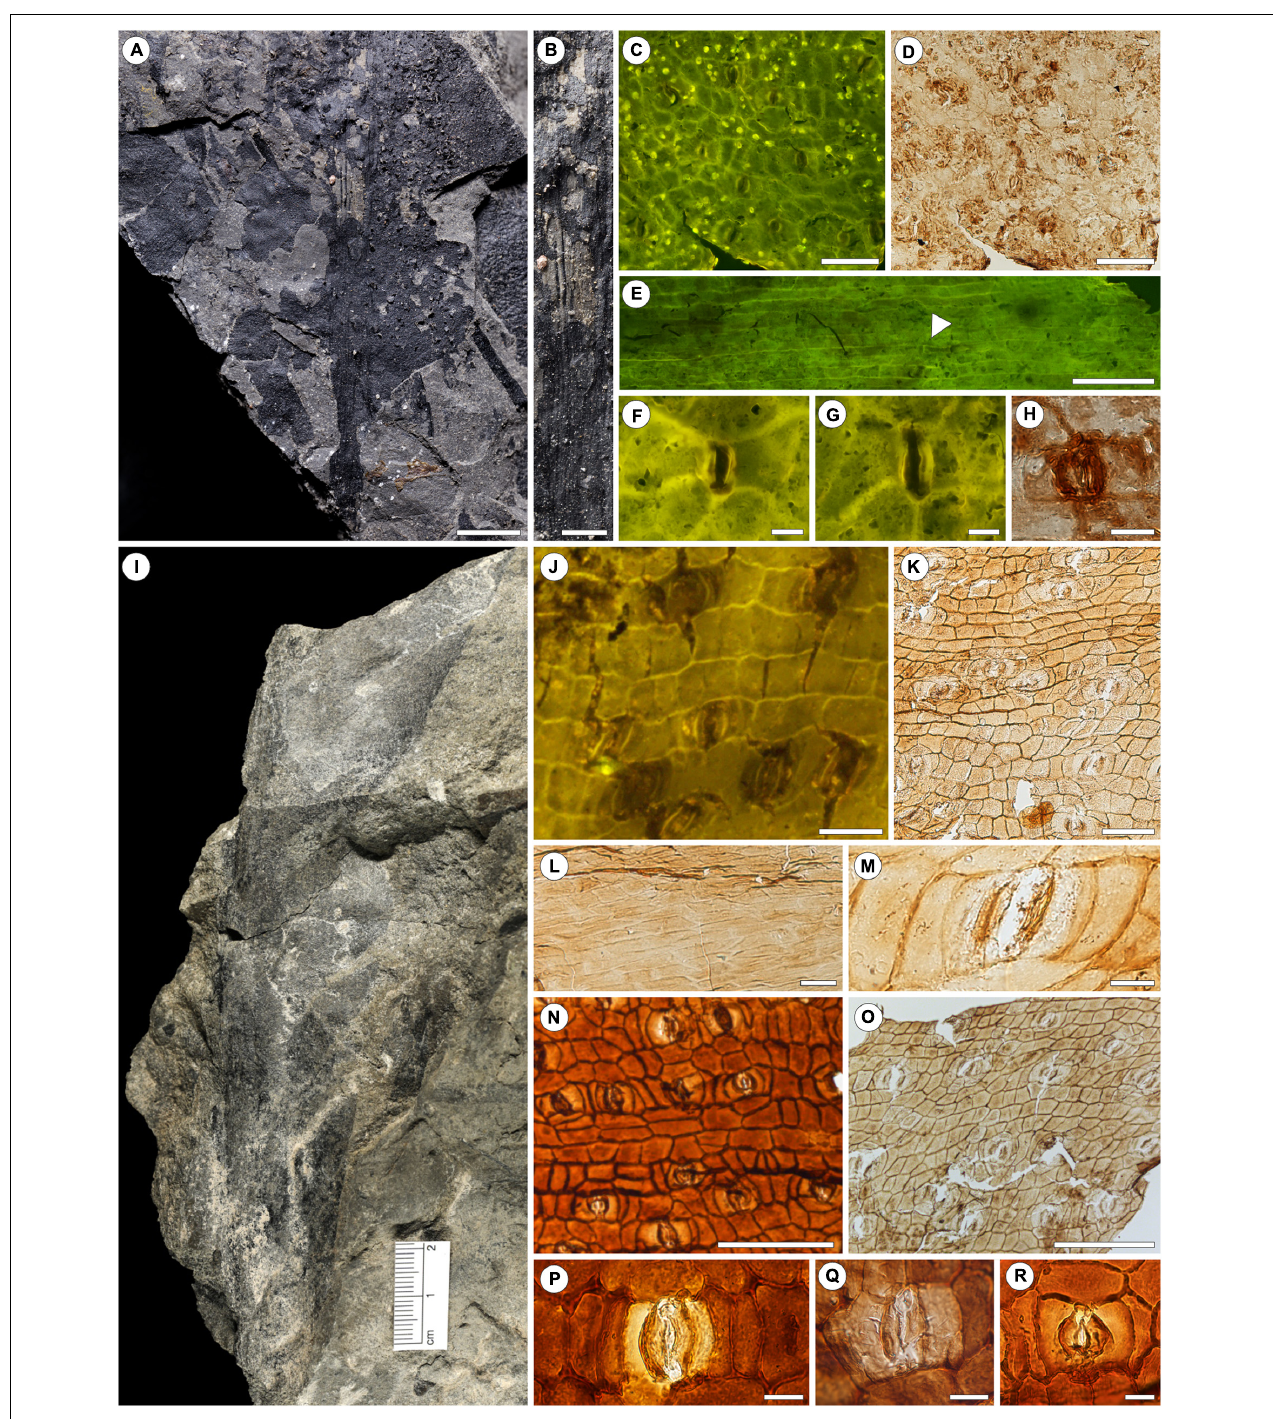
FIGURE 2 | Nilssoniopteris jogiana Blomenkemper et Abu Hamad sp. nov from the upper Permian of Jordan (A–G) and Nilssoniopteris shanxiensis Bäumer, Backer et Wang sp. nov. from the lower Permian of China (H–Q) . (A) Holotype of N. jogiana (Jo15-5-62) showing the partially preserved lamina and rachis. (B) Detail of (A) showing the striate rachis. (C) Lower leaf surface showing the costal field and unidentified organic particles. (D) Same section as C in transmitted light. (E) Upper surface of N. jogiana . Note the stoma (white arrow). (F,G) Epifluorescence image of typical stomata of N. jogiana from the lower leaf surface. (H) Typical stomata of N. jogiana in transmitted light. (I) Holotype of N. shanxiensis (PLG 137B-001). (J) In situ epifluorescence picture of the lower leaf surface (H) . (K) Light microscopic image of the lower leaf surface. (L) Epidermal architecture of the rachis. Note the strongly elongate epidermal cells. (M) Detail of (K) showing a typical stoma of the lower leaf surface. (N,O) Lower (N) and upper (O) leaf surface. Note the difference in stomatal density. (P–R) Typical stomata of N. shanxiensis . Scale bars for (A) = 1 cm; (B) = 5 mm; (C,D) = 100 µ m; (E) = 200 µ m; (F–H) = 20 µ m; (J) = 50 µ m; (K) = 100 µ m; (L) = 50 µ m; (M) = 20 µ m; (N,O) = 200 µ m; (P–R) = 20 µ m.